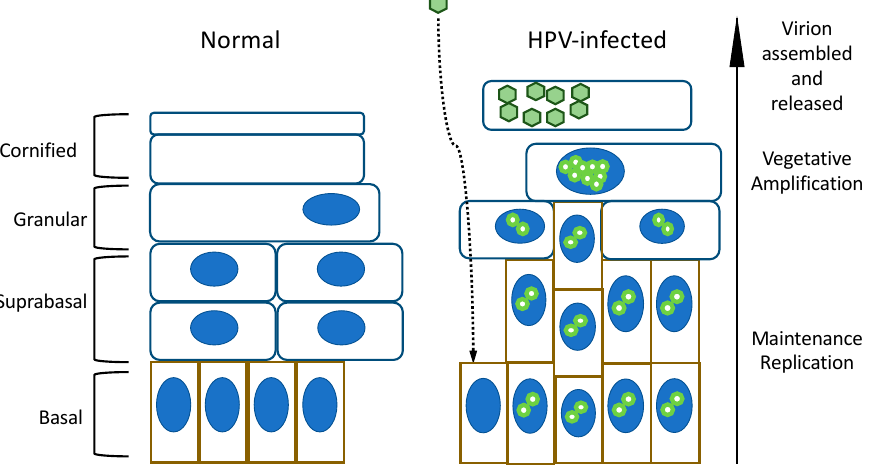
Figure 1. Comparison of normal stratified squamous and an HPV-infected epithelium. Infection occurs in the basal layer that contains proliferative cells. After an initial phase of genome replication in the infected host cells’ nuclei (blue ovals), the viral genomes (green circles) are maintained at a low copy number. Vegetative amplification occurs only in the differentiated layers of the epithelium. High-level viral DNA synthesis takes place in replication factories that form at sites of double-strand host cell DNA breaks. Viral progeny is produced and shed in the denucleated dead skin cells (“squames”) that slough off. See text for details and references.